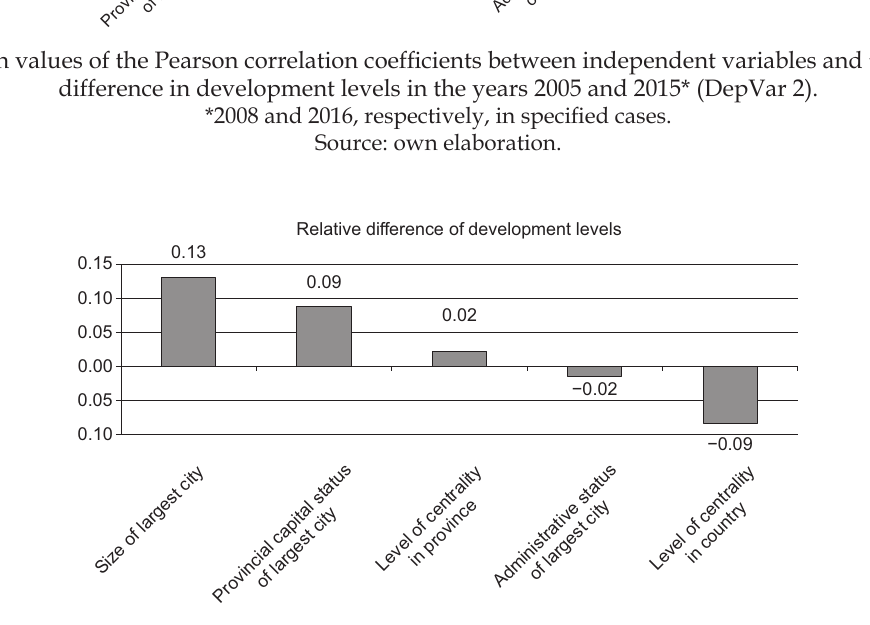
Fig. 6 Mean values of the Pearson correlation coefficients between independent variables and the relative difference in development levels in the years 2005 and 2015* (DepVar 3). *2008 and 2016, respectively, in specified